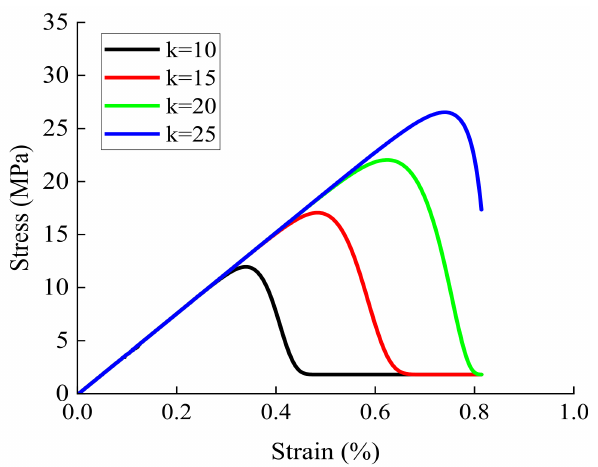
Figure 13. Sensitivity analysis of parameter k